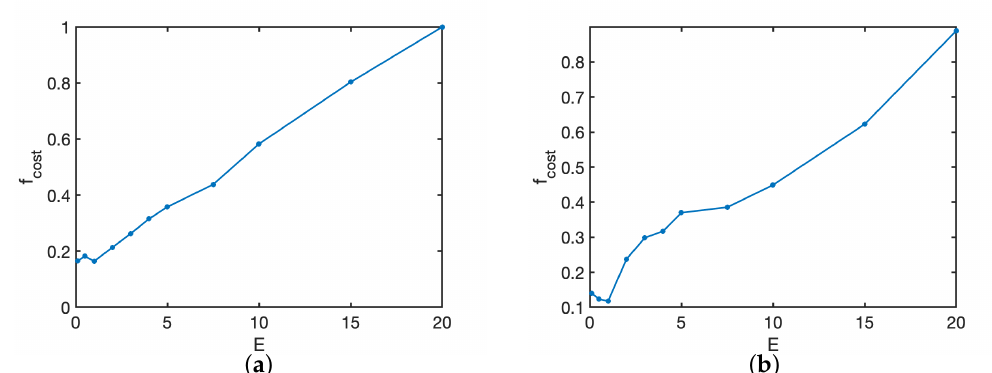
Figure 9. Target cost function with respect to E for ( a ) one actuator disc, and ( b ) set of four wind farms on the North Sea (219 turbines).